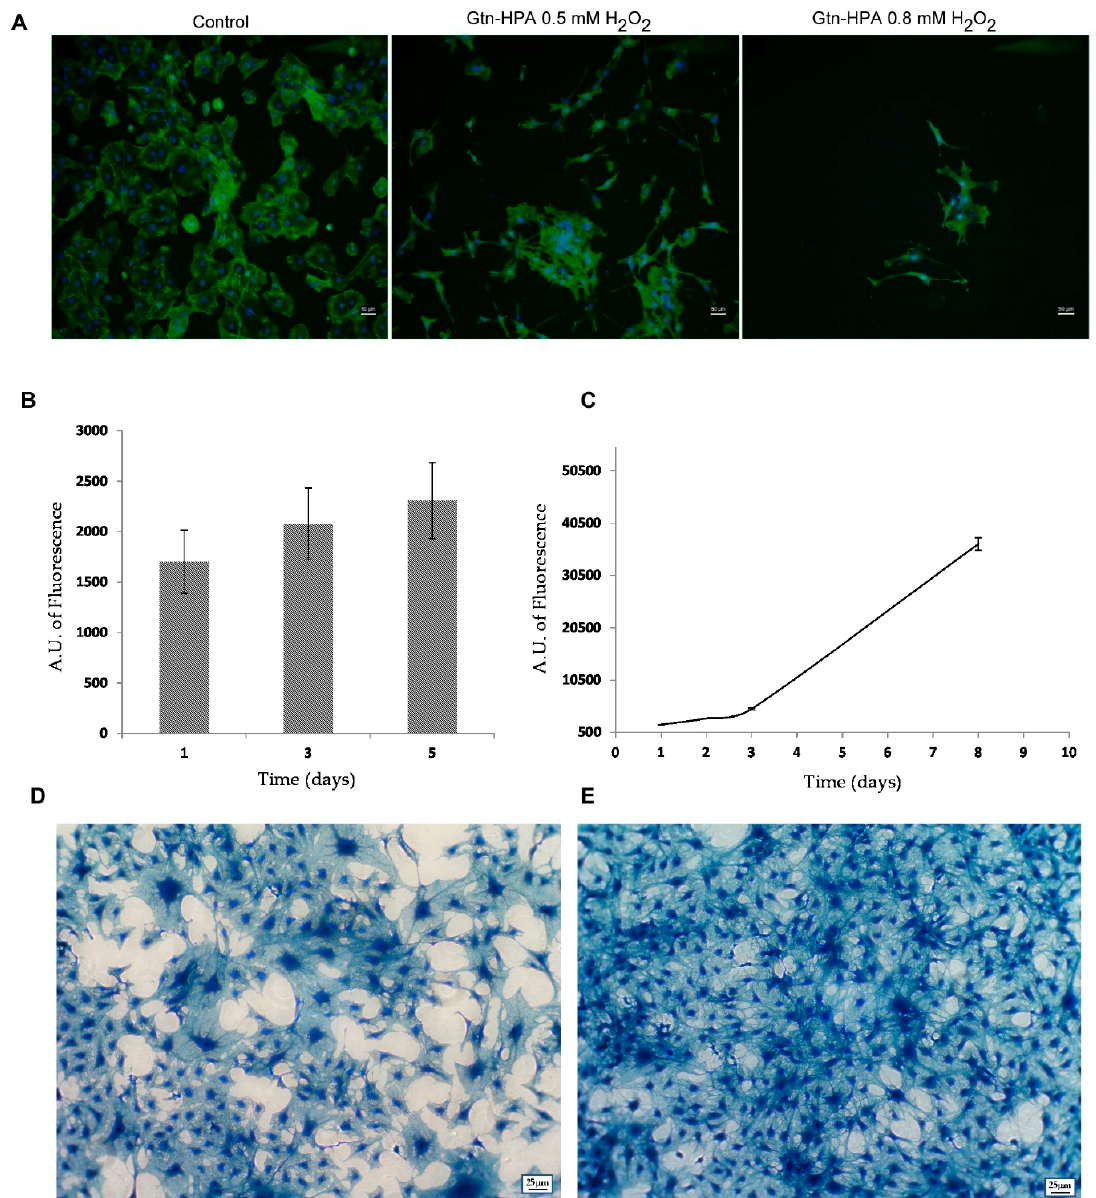
Figure 3. The use of 0.5 mM H 2 O 2 for enzymatic cross-linking does not impair cell viability. ( A ) Different and nontoxic H 2 O 2 concentrations do not modify cell morphology. MC3T3-E1 cells were grown, respectively, on cover glass as 2D control , in the Gtn-HPA hydrogel cross-linked with 2 U/mL HPR and 0.5 mM H 2 O 2 and in the Gtn-HPA hydrogel cross-linked with 2 U/mL HPR and 0.8 mM H 2 O 2 for 5 days. Cell cytoskeleton was stained with Phalloidin FITC (Green). Nuclei were stained with DAPI (Blue). Magnification was 10×. Scale bar was 50 μ m. ( B ) Proliferation assay of MC3T3-E1 cell growth within the Gtn-HPA hydrogel cross-linked with HPR and 0.5 mM H 2 O 2 . Bars represent mean ± SD ( n = 3) ( C ) proliferation assay of MC3T3-E1 cells recovered after 5 days in the Gtn-HPA hydrogel and then seeded on 2D; ( D ) contrast microscopy images of MC3T3-E1 cells after hydrogel recovery and seeded on 2D for 3 days and ( E ) for 8 days. Cells have been stained with Coomassie Brilliant Blue G. The magnification was 5 × ; scale bar was 25 µ